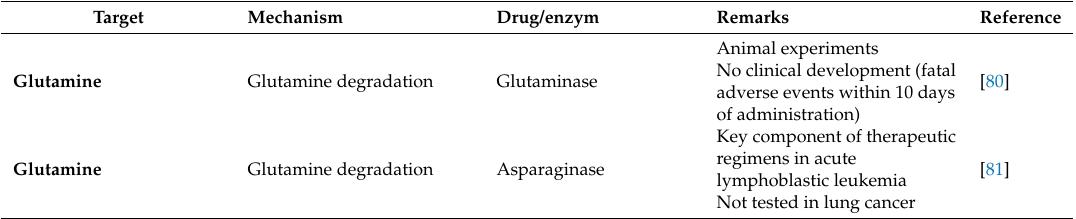
Table 1. Strategies for targeting glutamine